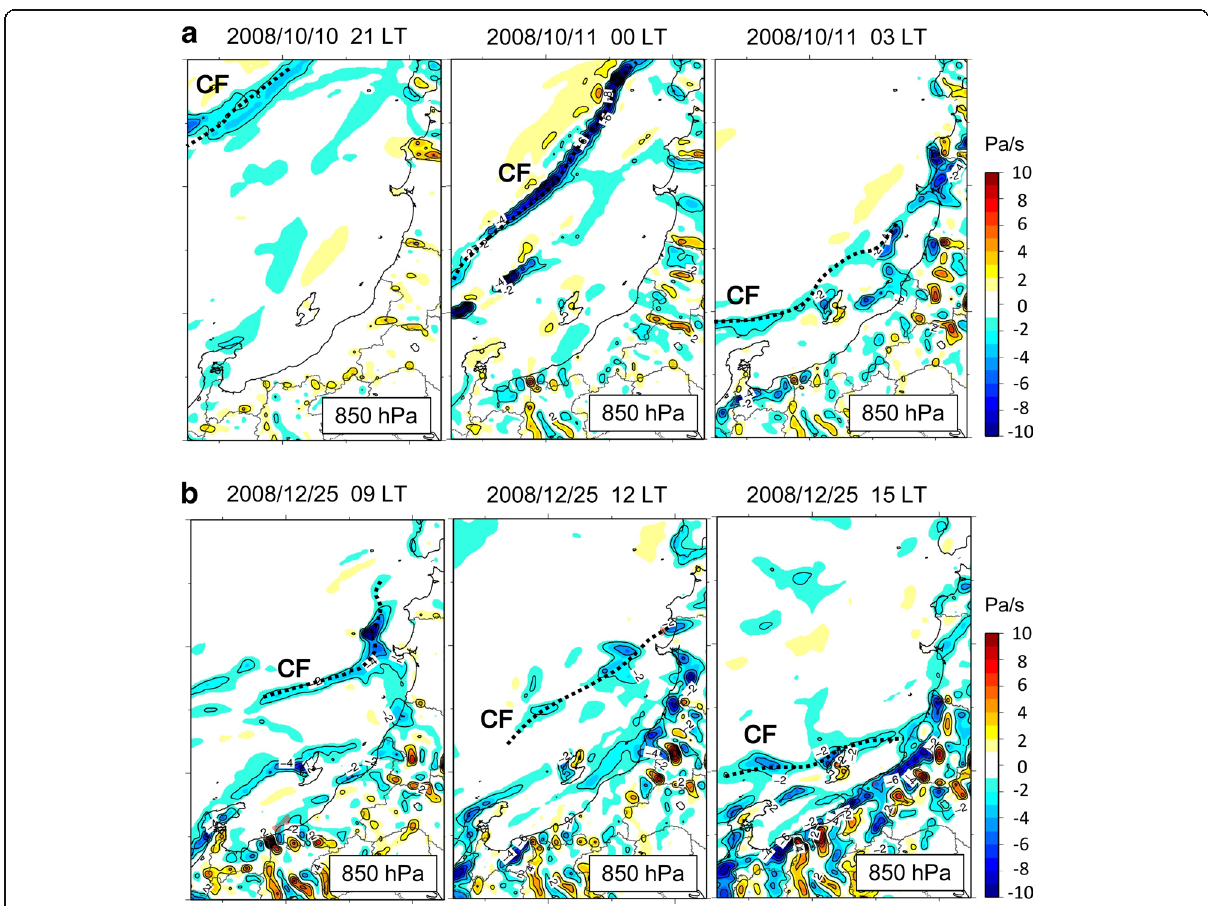
Fig. 20 a , b Comparison of vertical p -velocity (Pa/s) at 850 hPa for case A and case B. The vertical p -velocity data was obtained from